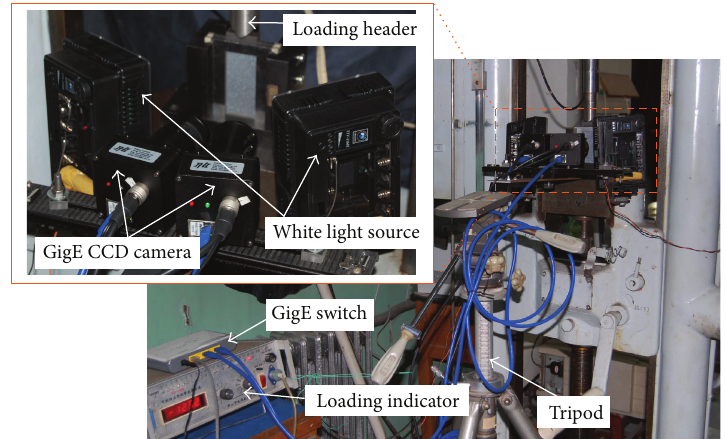
Figure 2: Experimental setup of 3D-DIC.